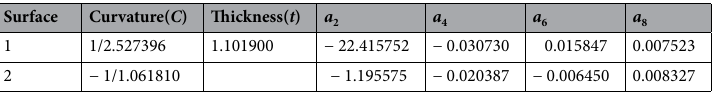
Table 2. Lens configuration data C, t , a 2 , a 4 , a 6 and a 8 obtained by the